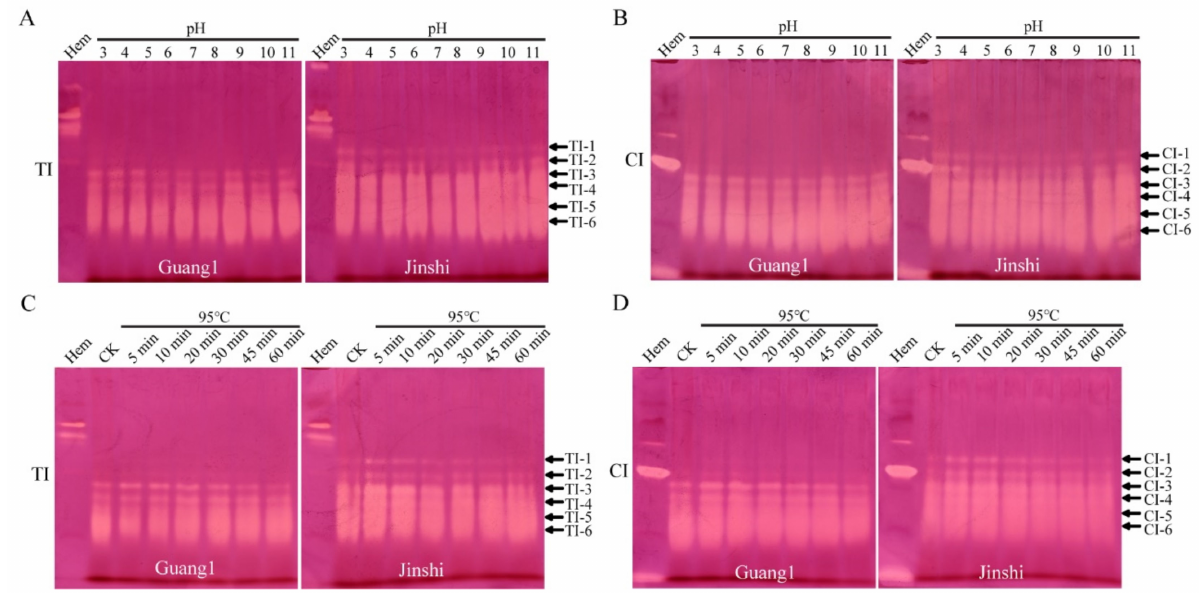
Figure 3. TIs and CIs from the leaves of Guang1 and Jinshi exhibited strong acid–base and thermal stability. Acid–base stability of TIs ( A ) and CIs ( B ) from leaves of mulberry varieties Guang1 and Jinshi. Thermal stability of TIs ( C ) and CIs ( D ) from leaves of mulberry varieties Guang1 and Jinshi. “TI” and “CI” represent trypsin inhibitor and chymotrypsin inhibitor, respectively. B. mori hemolymph from day-5 fifth-instar larvae represented by “Hem” was used as positive control. The arrows show activity-stained bands of trypsin inhibitors and chymotrypsin inhibitors, which are named “TI-1~TI-6” and “CI-1~CI-6” from top to